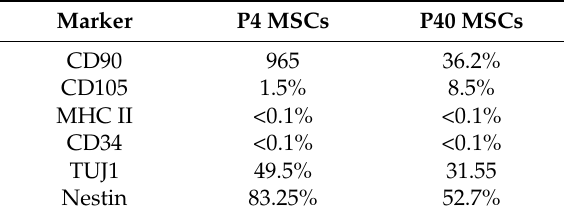
Table 1. Flow cytometry analysis of bone marrow derived mesenchymal stem cells (MSCs).